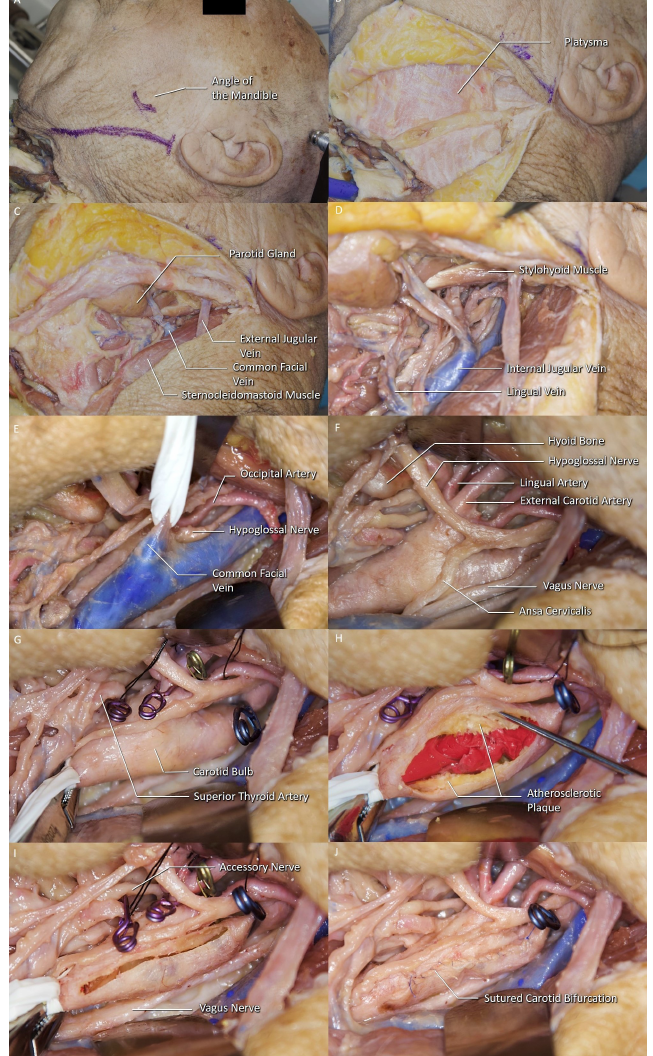
Figure 1. Stratigraphic dissections following the classical CEA procedure. ( A ) Marking for skin incision can be seen along the medial edge of the sternocleidomastoid muscle (SCM). ( B ) The divided platysma can be seen. ( C ) The common facial vein can be seen along the medial edge of the SCM. ( D ) The IJV is exposed with its tributaries, common facial and lingual vein. ( E ) Common facial vein is isolated prior to its ligation. ( F ) The IJV was retracted laterally to expose the hypoglossal nerve (HN) and the carotid bulb (carotid sinus). ( G ) The view of the carotid bulb after crossclamping. ( H ) A longitudinal incision on the carotid starting from the proximal end of the plaque extending to the internal carotid artery (ICA) can be seen. ( I ) The carotid bulb after the plaque removal. ( J ) The sutured carotid and the last clamp on the ICA can be